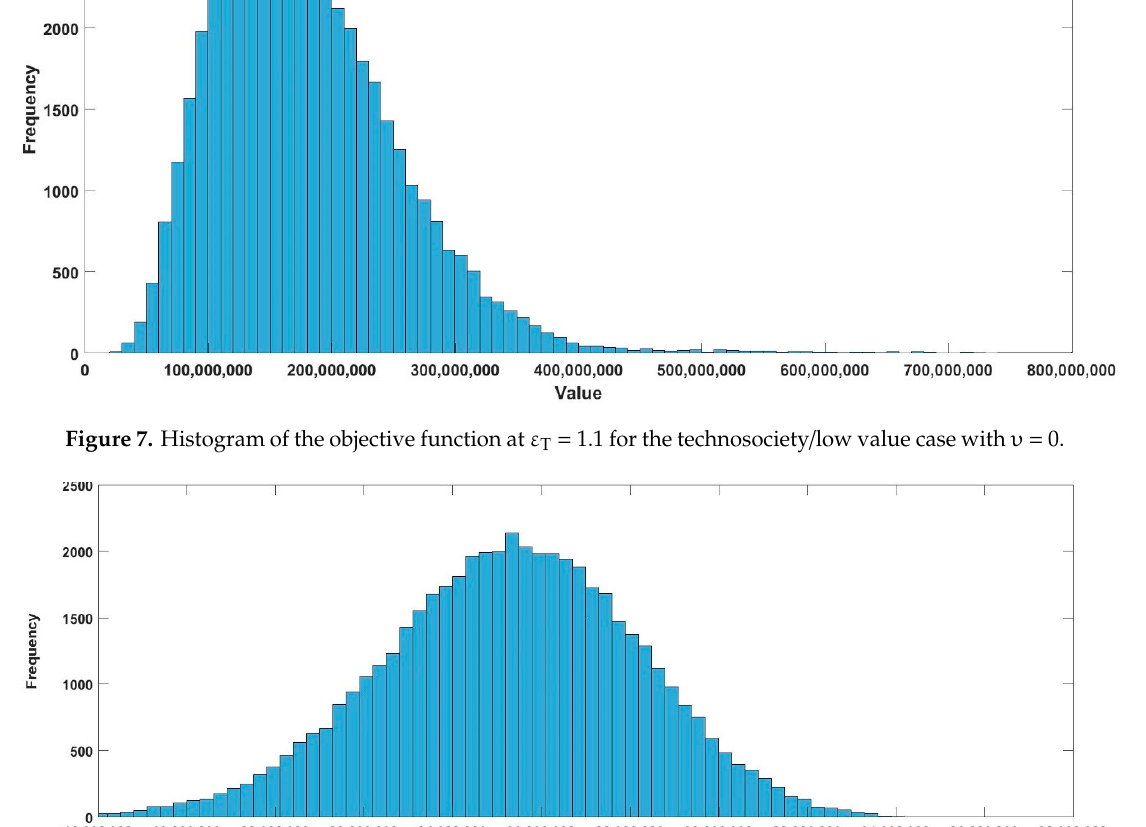
Figure 8. Histogram of the objective function for the greensociety / low value case.